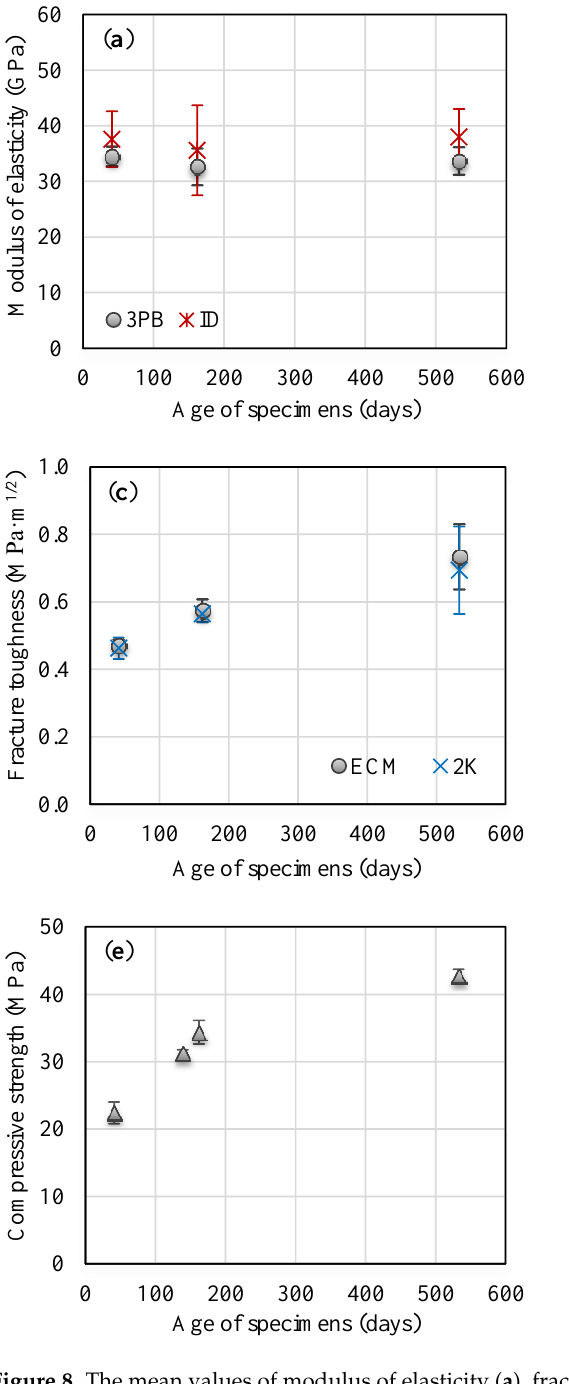
Figure 8. The mean values of modulus of elasticity ( a ), fracture energy ( b ), fracture toughness ( c ), fracture toughness/load ratio ( d ), compressive strength ( e ), and flexural/tensile strength ( f ) of the investigated AAS composite during the specimen’s aging (3PB—direct evaluation of particular parameter from fracture test, ID—identification of particular parameter, ECM—effective crack model, 2K—double- K fracture model).